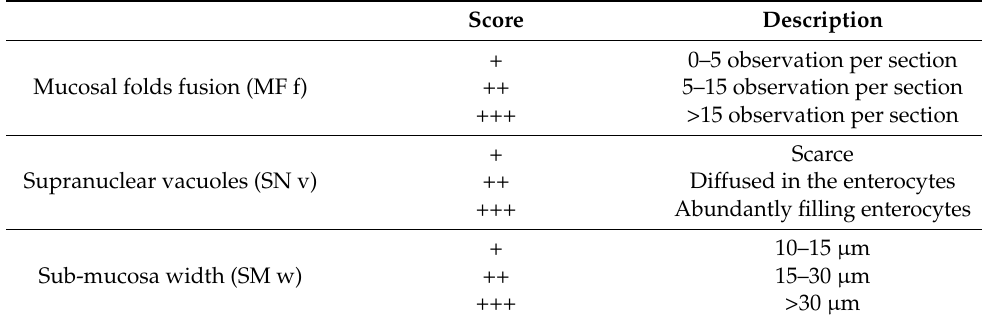
Table 2. Semi-quantitative scoring system for the different parameters used as histopathological indexes of enteritis in gilthead seabream